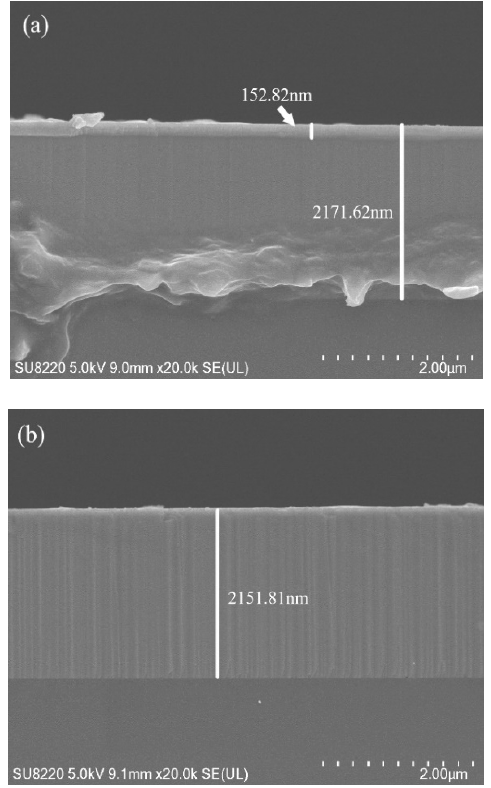
Figure 1. Scanning electron microscope (SEM) cross-section micrographs for Be-implanted gallium nitride (GaN) (BeGaN / GaN / sapphire model structure): ( a ) unannealed sample; ( b ) post-implantation rapid thermal annealing (RTA) at 1100 ◦ C